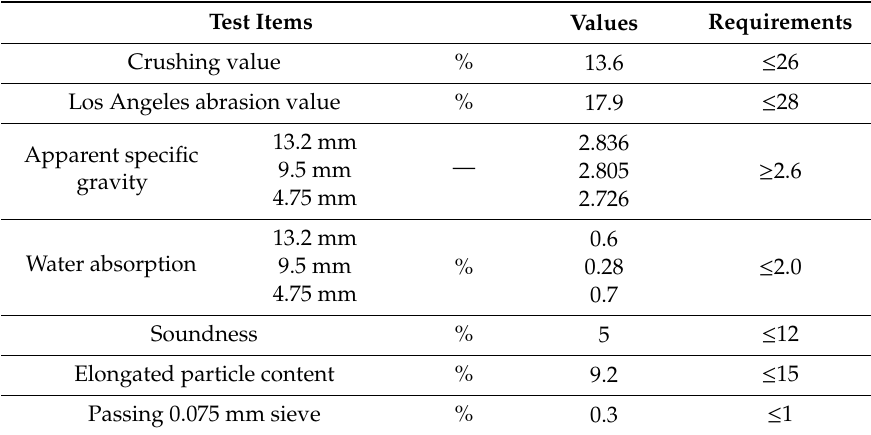
Table 2. Technical properties of basalt coarse aggregates.